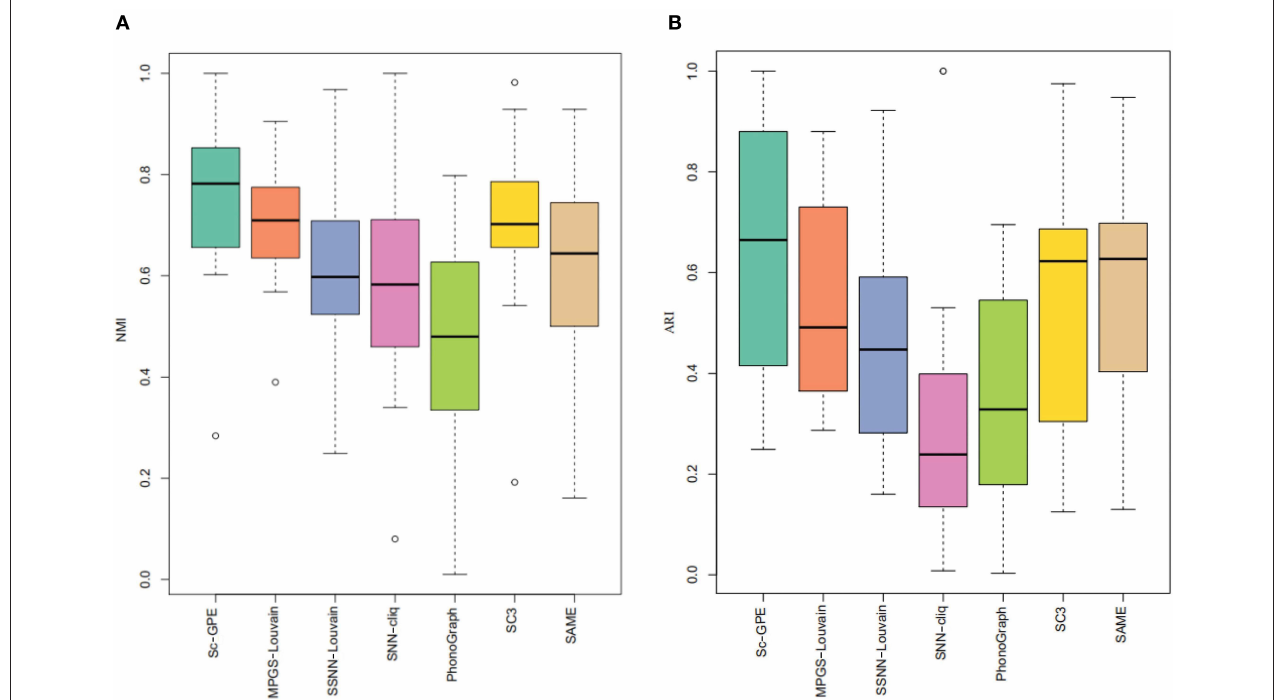
FIGURE 4 | The box plot of performance for the seven methods. (A) NMI; (B)